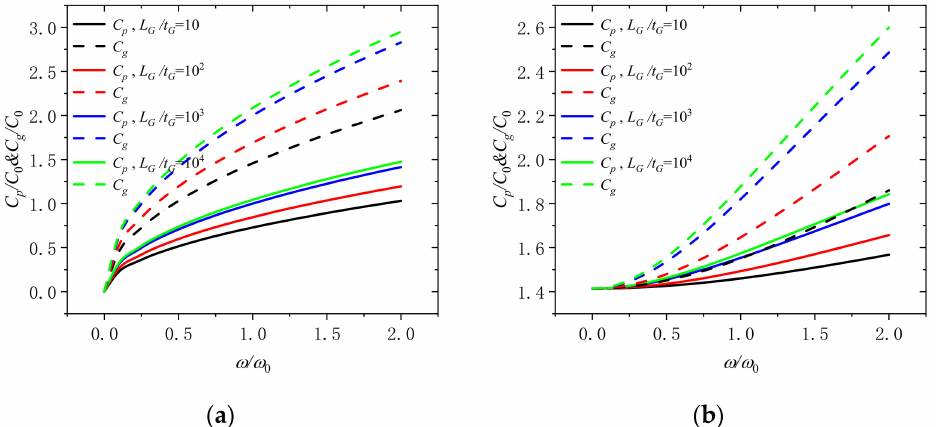
Figure 6. Phase speed and group speed in a rotating microbeam with different length thickness ratio of GPLs ( L G / t G = 10, 10 2 , 10 3 , and 10 4 ) for ( a ) Ω / Ω 0 = 0 and ( b ) Ω / Ω 0 = 2. Figure 7 reflects that the wave number varies with dimensionless frequency for dif- ferent GPLs length width ratio ( L G / W G = 1, 2, 4, and 8) under the dimensionless rotation speeds of 0 and 2. It suggests that the wave number rise with the increase of the length width ratio of GPLs in the microbeam. If the content of GPLs is fixed, low length-width ratio ratio means that the GPLs can obtain a larger surface area. It signifies that we should take GPLs with larger surface area into microbeams to enhance the microbeam.